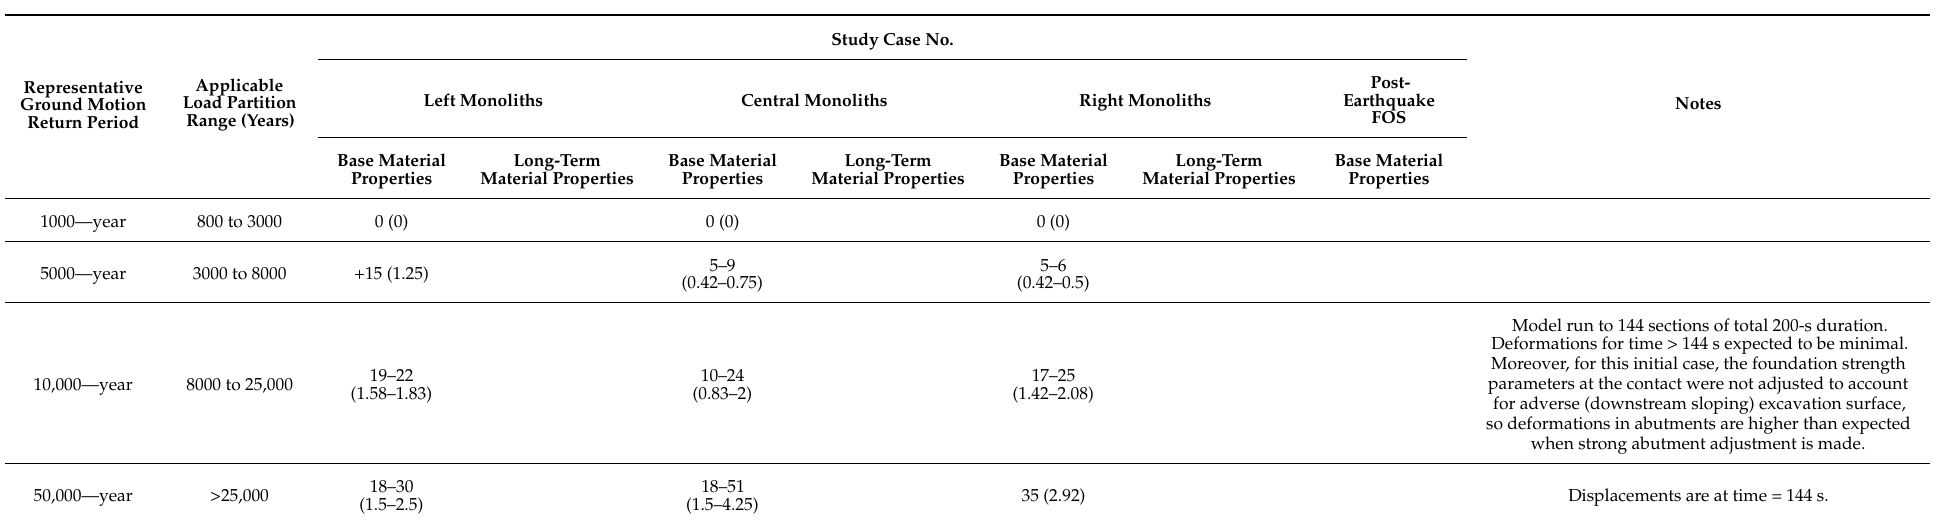
Table A4. Summary of study case results for risk analysis—Columns 3 through 8 show estimated monolith deformations in inches (feet)—SRCH10 (long duration CSZ ground motion). Column 2 shows the seismic load partition range used in the Risk Analysis for which the representative ground motion return period (shown in Column 1) was used to assess the performance of the